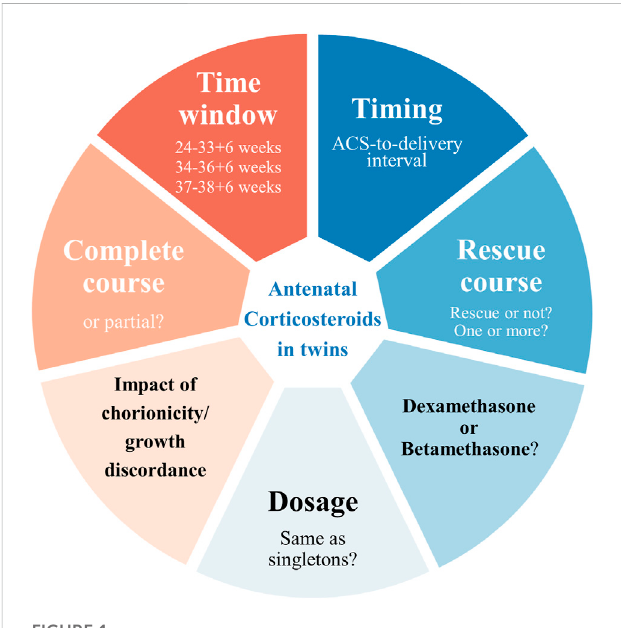
FIGURE 1 Controversies of antenatal corticosteroids in twin